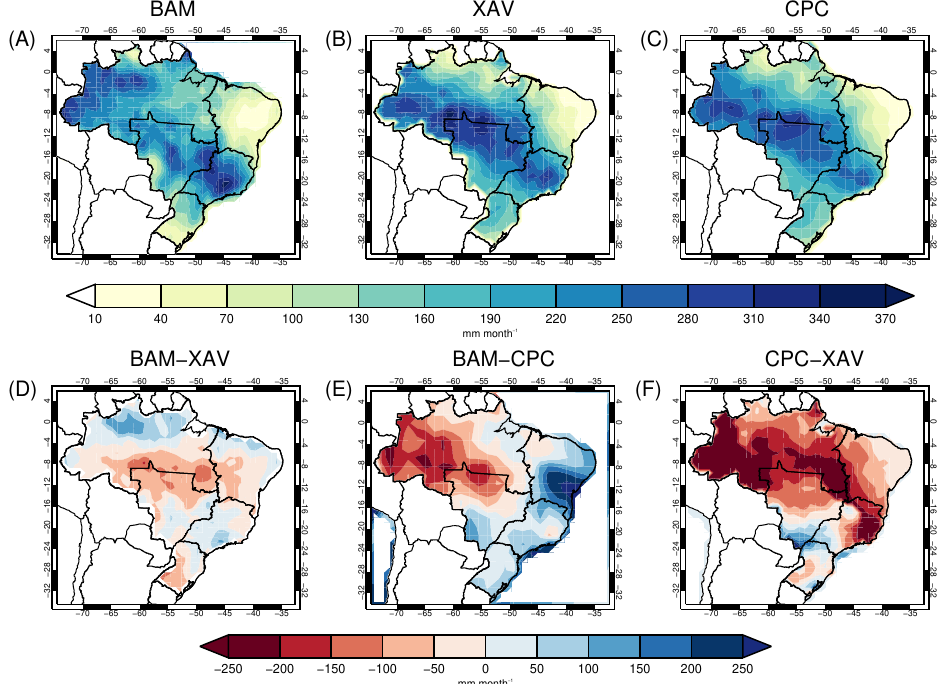
Figure 3. Mean monthly precipitation (mm month − 1 ) (1990–2015) during the extended summer (October–March) from the BAM ( A ), XAV ( B ), and CPC ( C ) (upper panel). Mean monthly precipitation difference between the BAM and XAV ( D ), between the BAM and CPC ( E ), and between the CPC and XAV ( F ) (lower